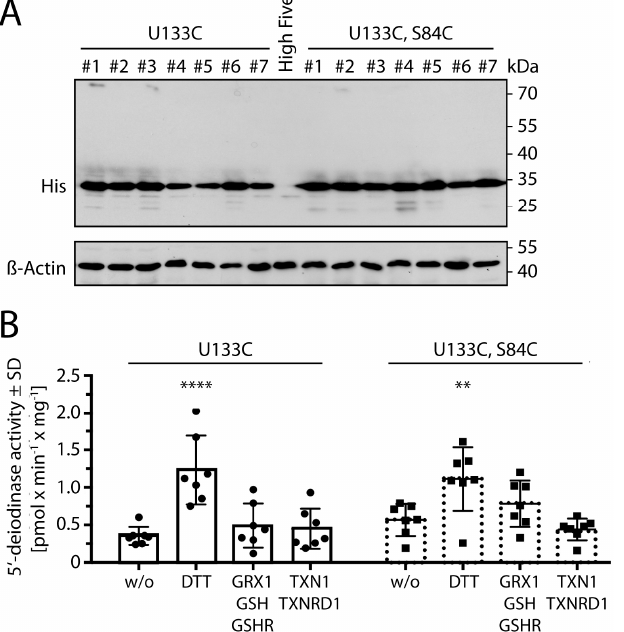
Figure A2. Recombinant expression of human DIO2 in insect cells . ( A ). Western blot against the C-terminal His-tag of DIO2 U133C and DIO2 U133C/S84C . Shown are independent transductions with viral particles. High Five denotes non-transduced cells which served as a negative control. Western blot against β -actin was used to show similar protein content. ( B ). 5 (cid:48) -deiodinase activity of insect cells transduced with human DIO2 U133C -expressing constructs in relation to the reducing co-factors used. DIO2 U133C exhibits activity in the presence of the artificial reductant DTT (20 mM), while physiological regenerating reducing systems with 1 mM GSH, 0.05 µ M GSHR, and 200 µ M NADPH; or 3 µ M TXN1 and 0.1 µ M TXNRD1; and 200 µ M NADPH did not support activity beyond the first turnover that occurs even in the absence of reductant (“w/o”). The mutation S84C does not increase activity. ** p < 0.01, **** p < 0.0001, Student’s t test compared to enzyme without (w/o) reductant. Symbols denote means of individual experiments (#1–7) performed in triplicates. SD: standard